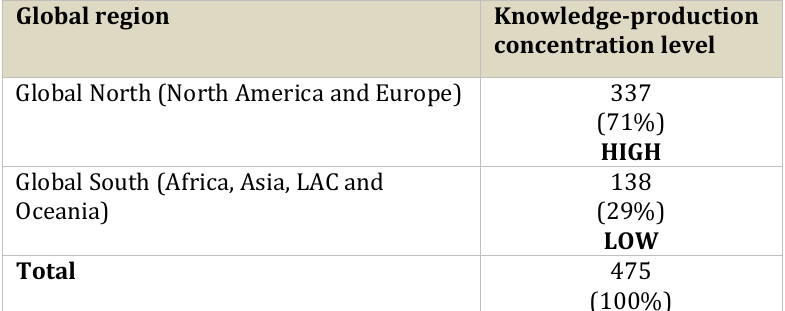
Table 4: Level of knowledge-production concentration in Crimes of the powerful studies globally according to where the studies are focused or developed (WoS Core Collection search, n=475